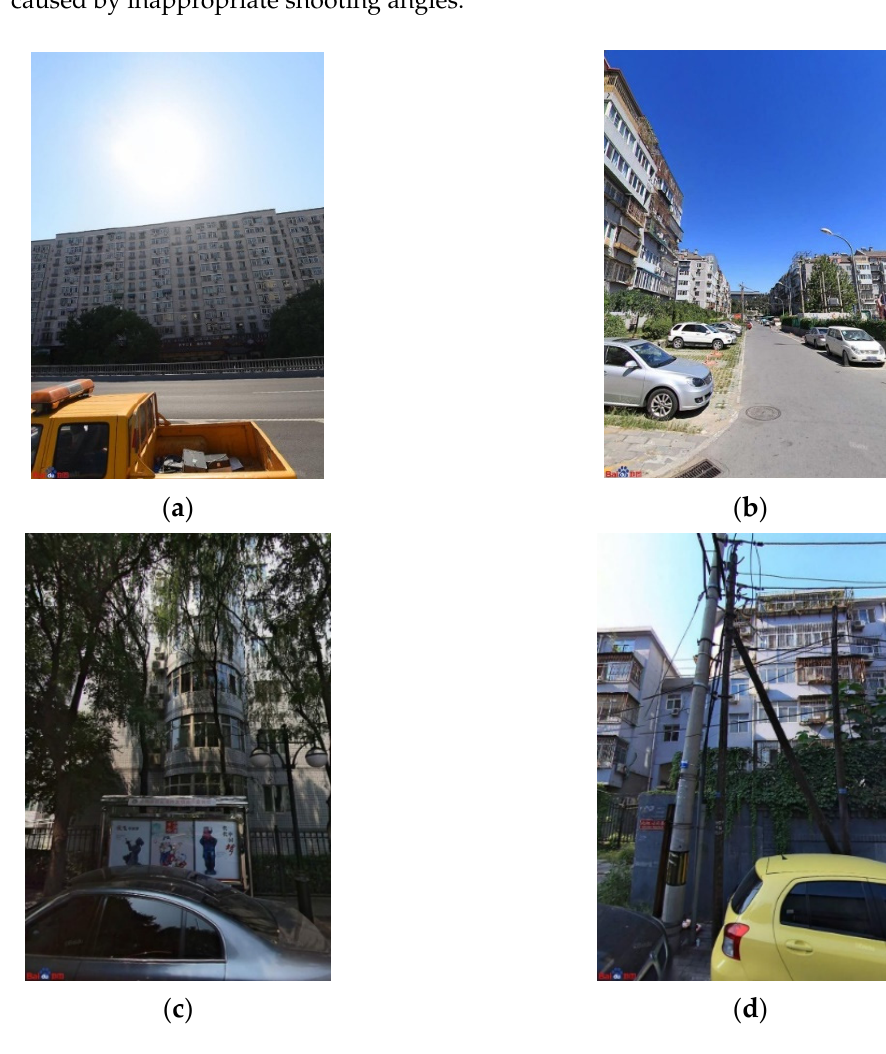
Figure 1. Examples of deficient performance of several street view images, including: ( a ) occupying a small proportion of several street view images; ( b ) excessive deviation of the camera angle value; ( c ) urban street vegetation covering; ( d ) covering by other objects.